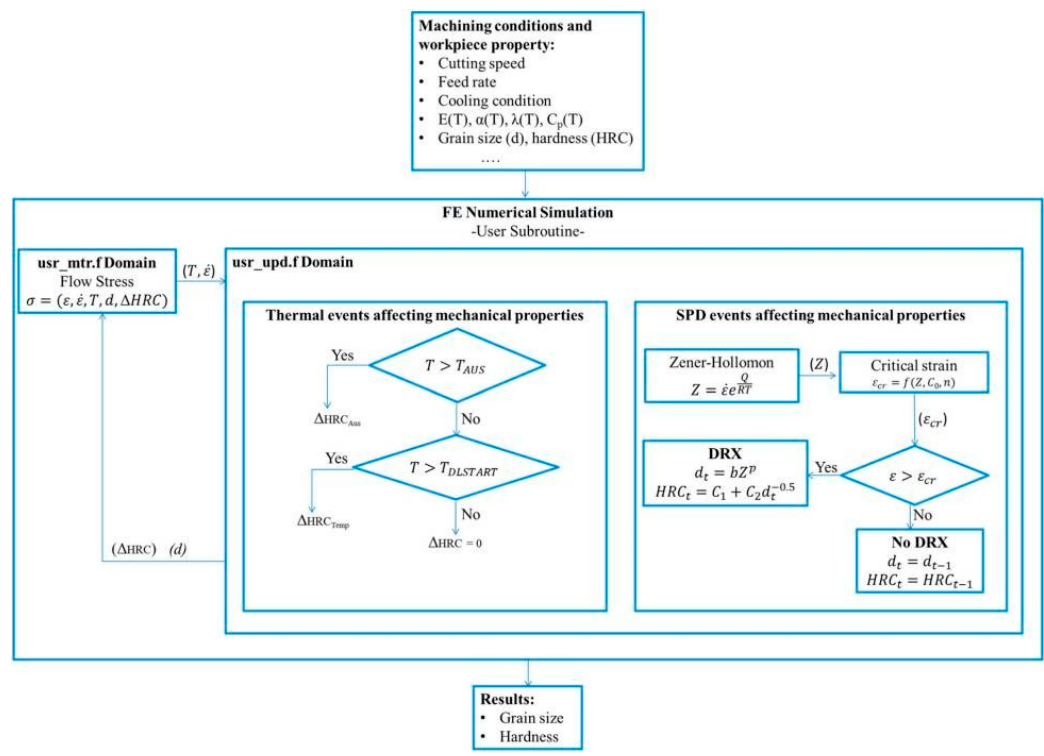
Figure 2. Finite element strategy to predict the grain size and hardness variation due to thermal and mechanical events.